Question: In one sentence, what is this figure communicating?
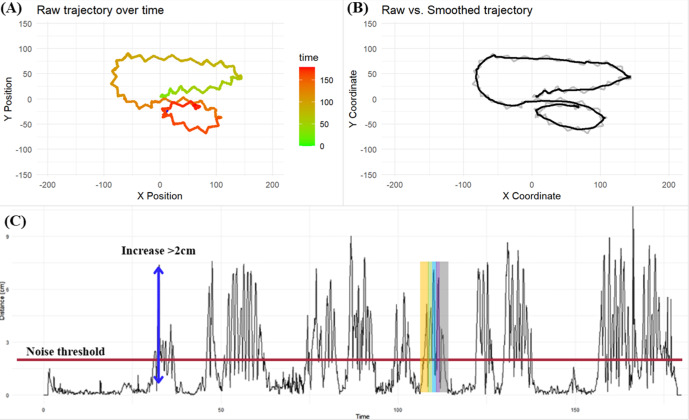
Answer: Broiler ambulation coordinate plots from an open field test for the (A) raw trajectory over time, (B) 40-point moving average smoothed trajectory (black line) overlaying the raw trajectory (grey zigzag), and (C) the plotted Euclidean distance between sequential coordinates over time; a ‘step’ was defined as an increase in Euclidean distance greater than 2 cm (blue arrow) from the initial deviation point to the subsequent peak. The highlighted section indicates a series of five steps, where each colour indicates the start and end of each step. Figure 1 long description.